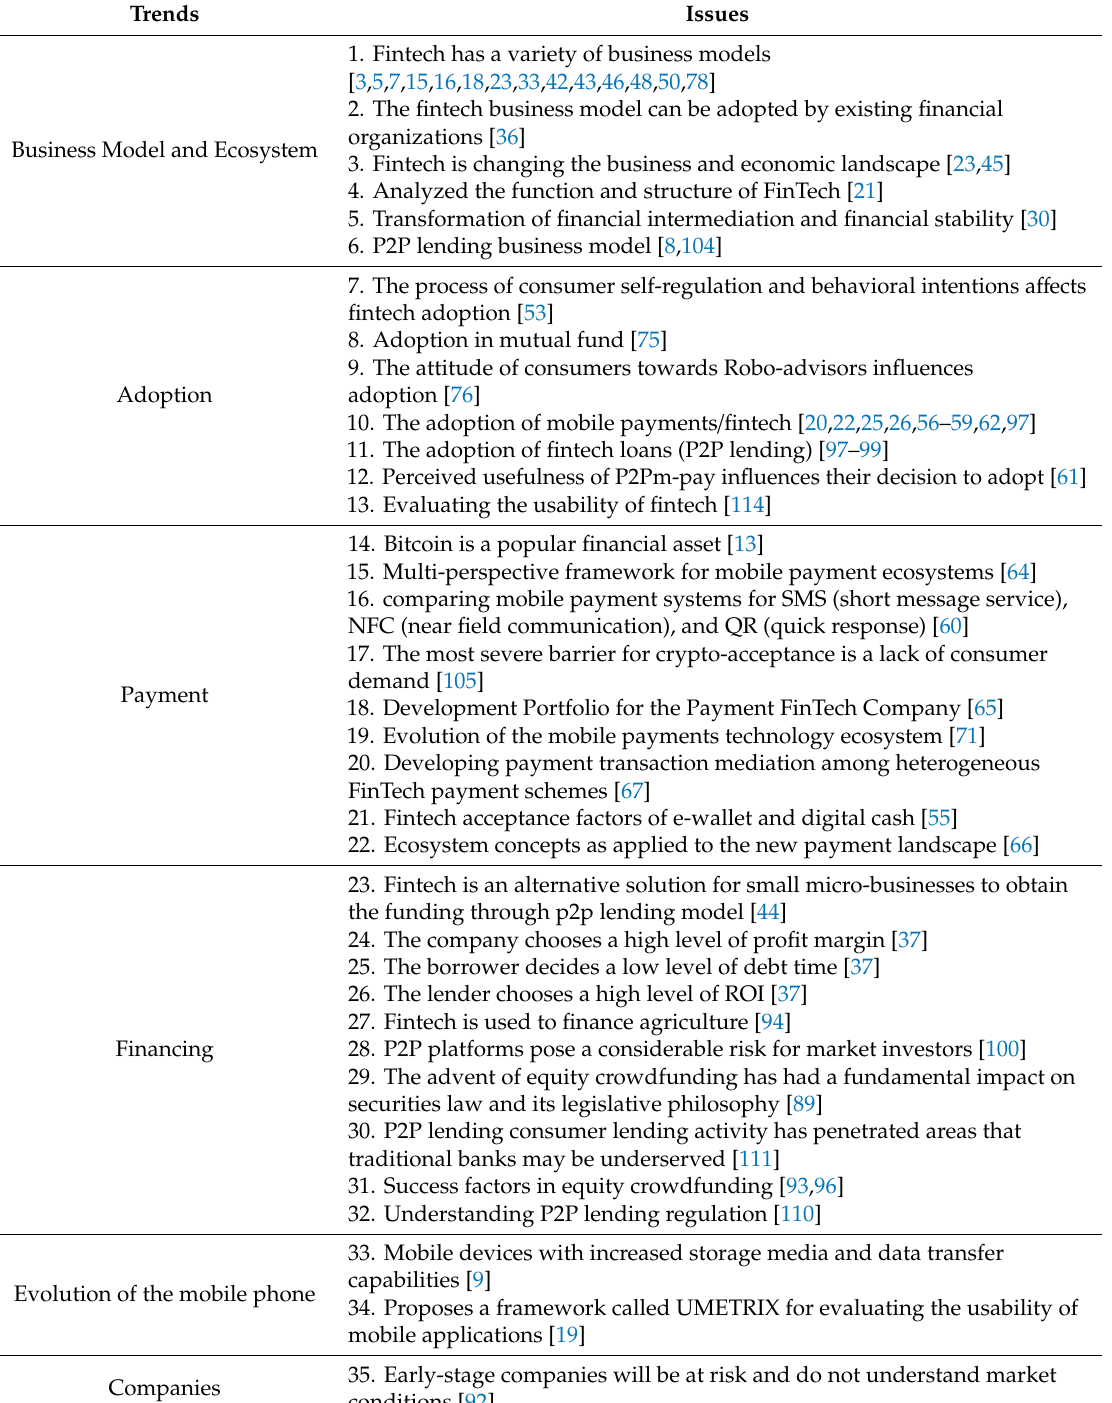
Table 6. Research